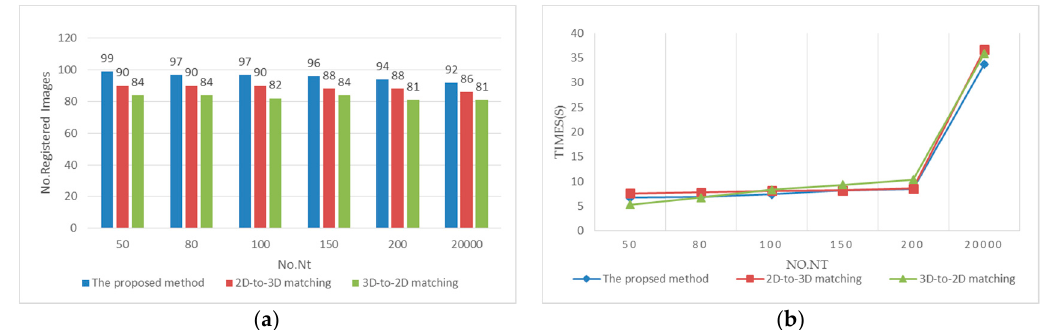
N : ( a ) comparison of the effectiveness t